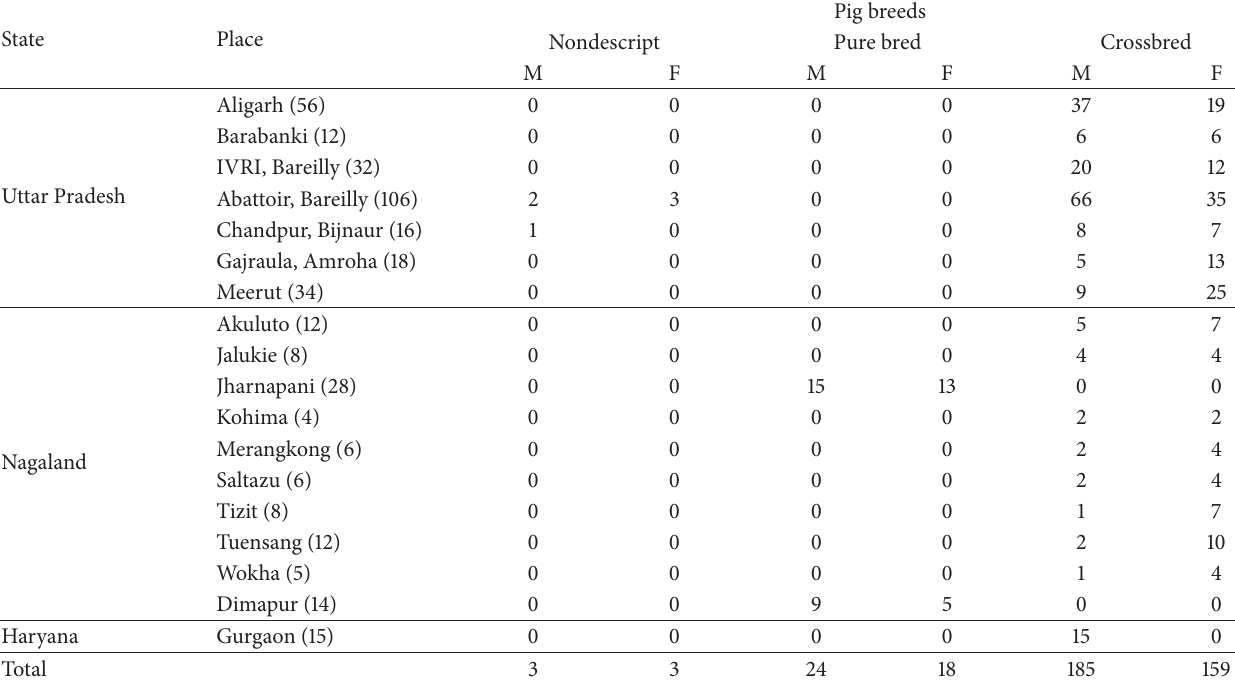
Table 2: Details of samples collected from pigs at different